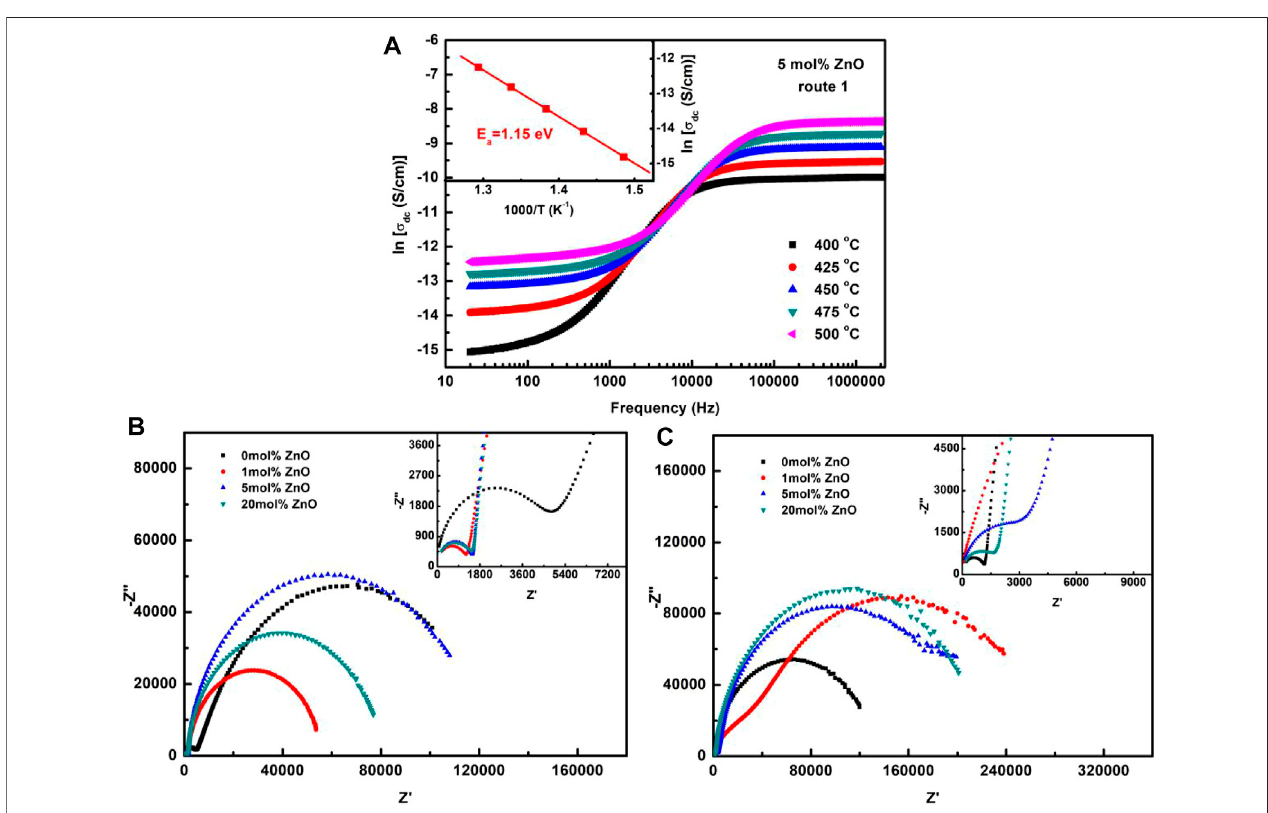
FIGURE 3 | (A) AC conductivity and Arrhenius fi tting results for CST-5mol% ZnO ceramics prepared via process route 1 and complex impedance spectra (at 425 ° C) for CST-ZnO ceramics prepared via (B) process route 1 and (C) process route 2.